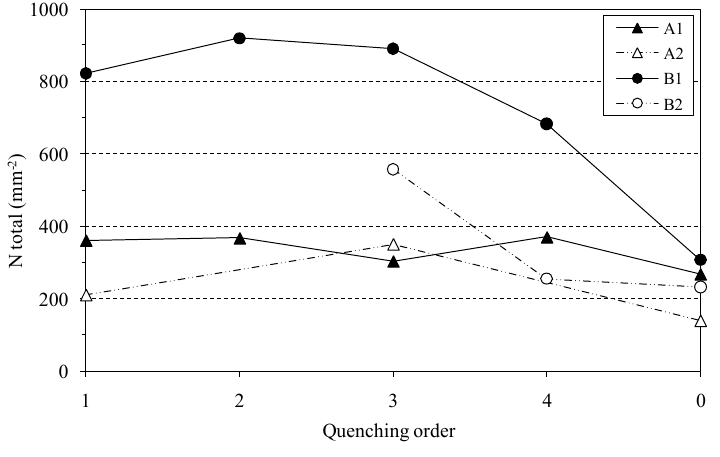
Figure 11. Total nodule count evolution with all quenched